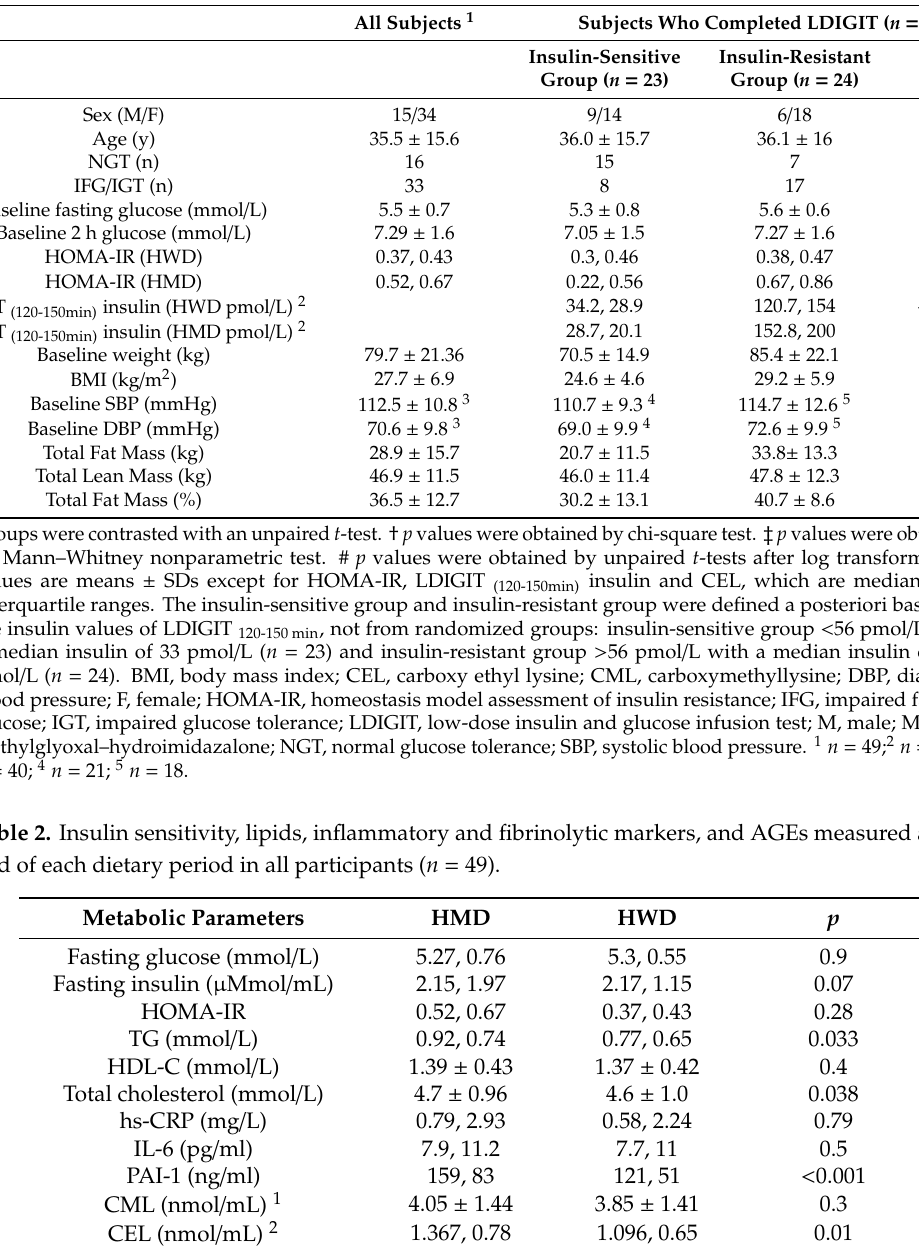
Table 1. Baseline characteristics of subjects.